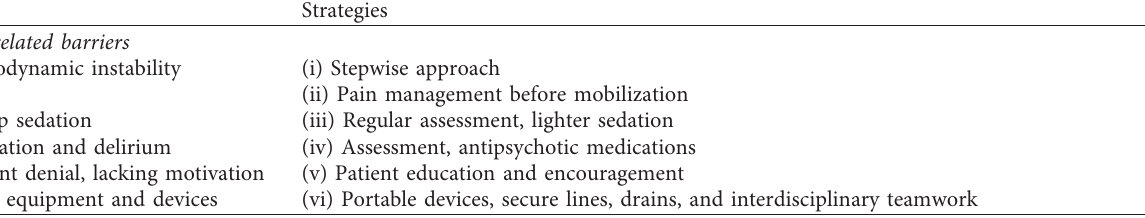
Table 11: Strategies for overcoming